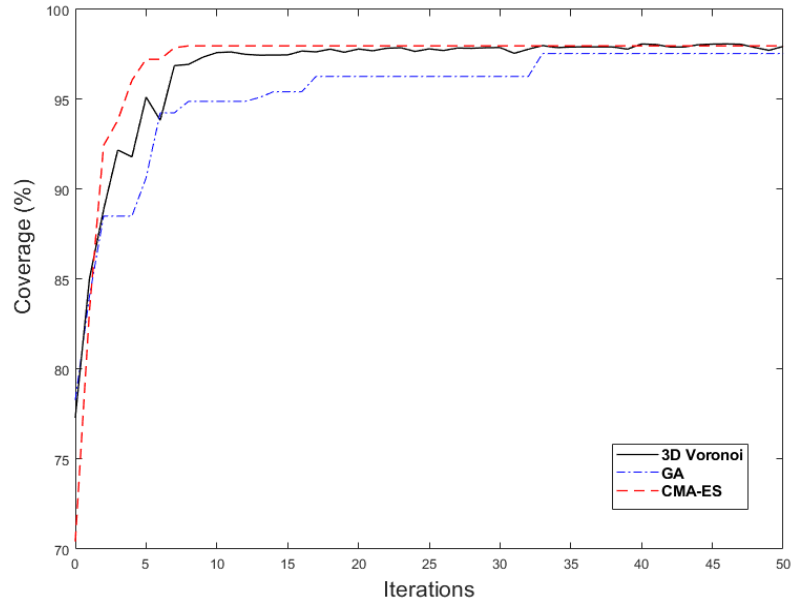
Figure 13. Convergence diagrams of 3D Voronoi, GA, and CMA-ES. Table 1. Results of 3D Voronoi, GA, and CMA-ES algorithms including coverage average (AVG- coverage) and its standard deviation